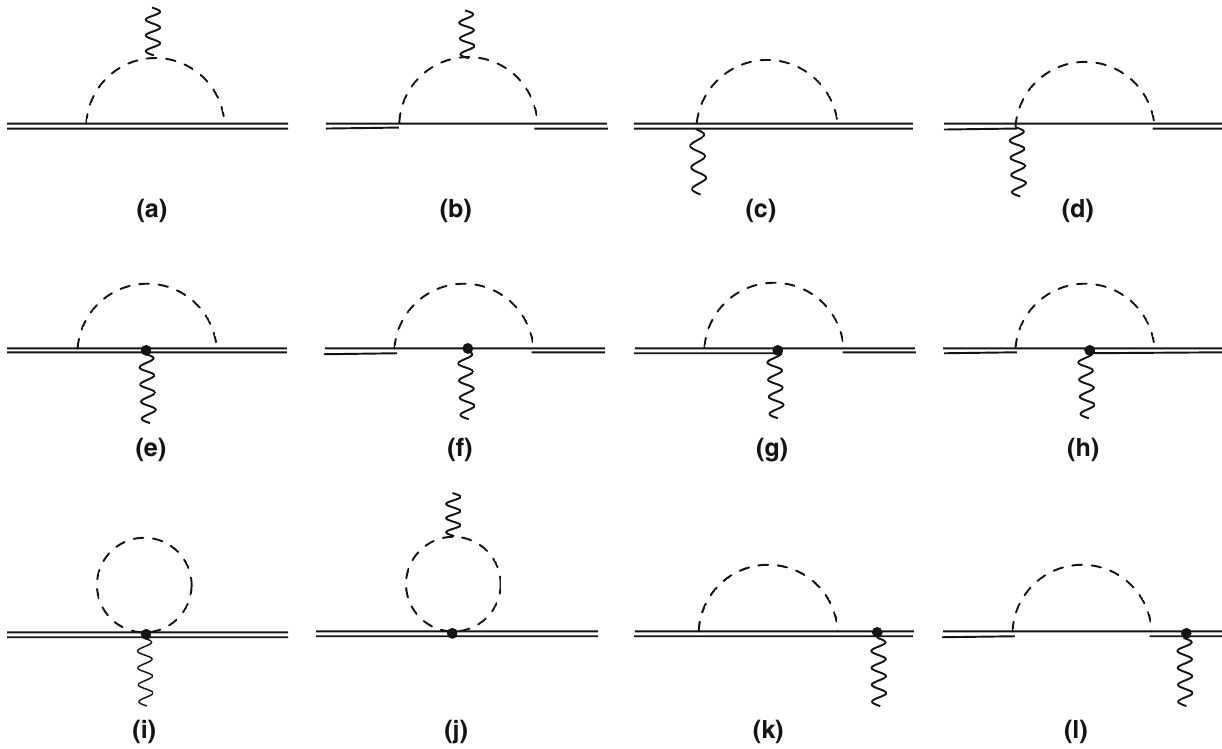
(spin- 1 ) doubly charmed baryon is denoted by the double (single) solid line. The dashed and 2 2